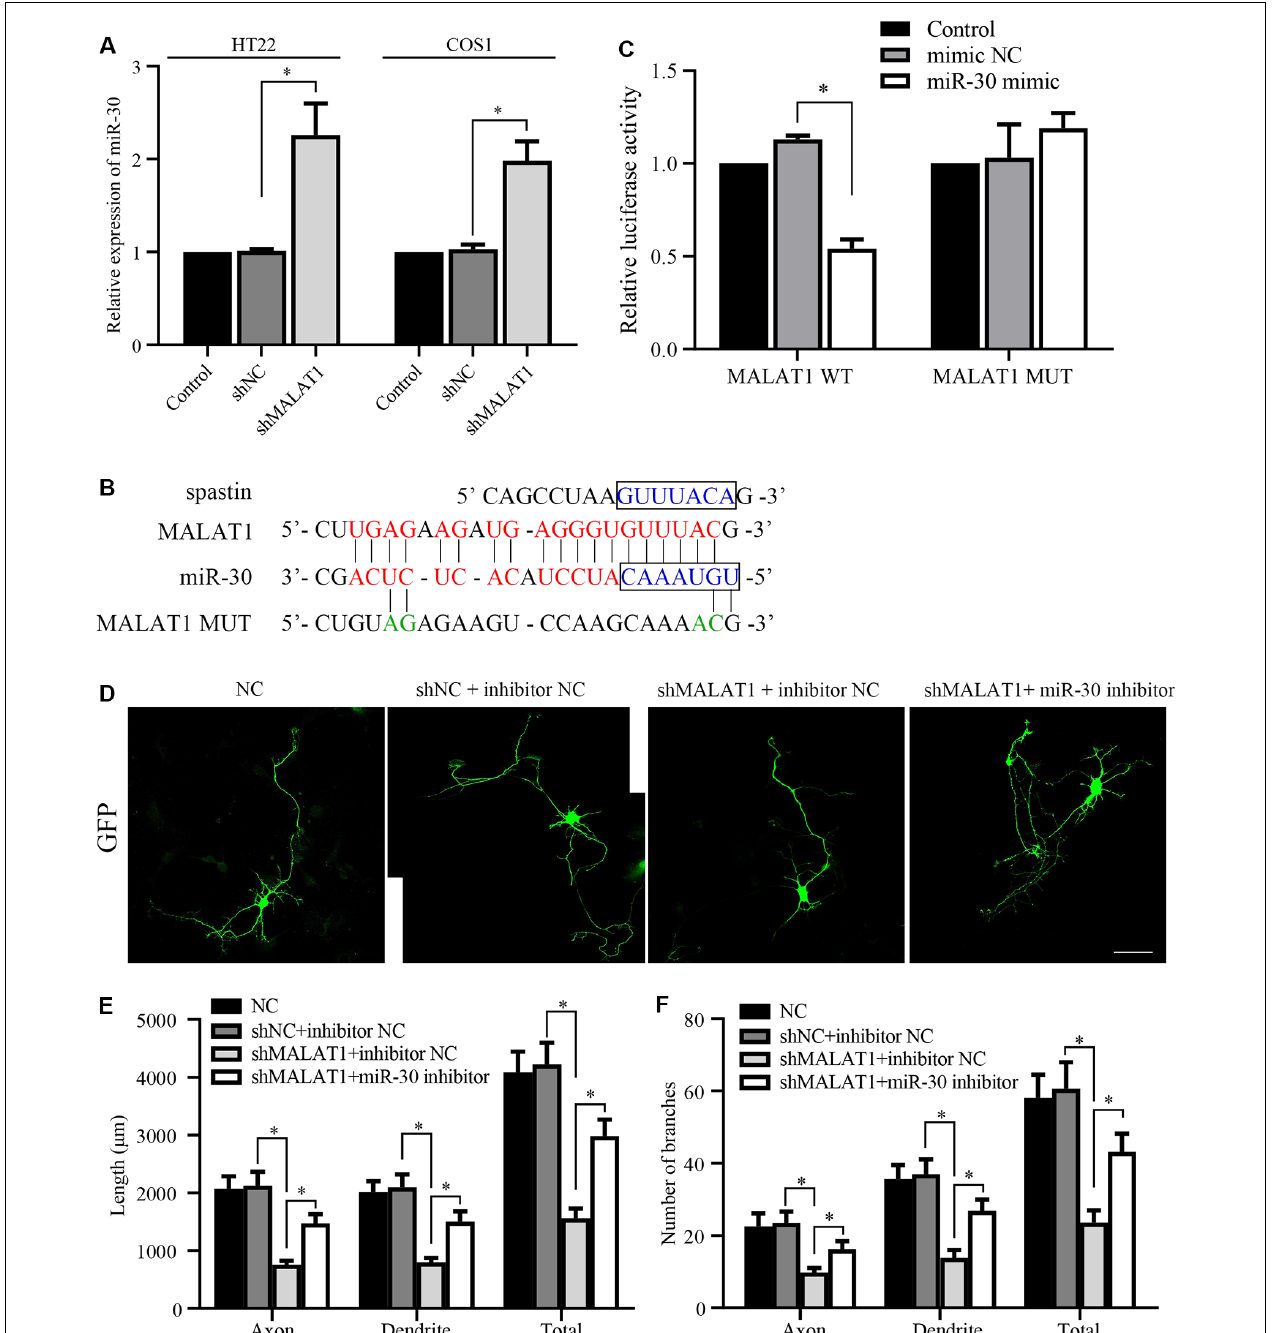
FIGURE 4 | lncRNA MALAT1 targets miR-30 during neural development. (A) The expression levels of miR-30 were determined by qPCR in HT22 and COS1 cells transfected with shMALAT1 or control plasmids. (B) Alignments of the luciferase reporter plasmids encoding MALAT1 WT or MUT against miR-30. (C) The reporter plasmids were transfected together with or without miR-30 mimics, and the relative luciferase activity was quantified. (D) Representative images of the cultured neurons that were transfected with the shMALAT1 plasmids or miR-30 inhibitors. Neurite lengths (E) and the number of branches (F) were quantified (neuron number > 30/group of each experimental repeat). ∗ P < 0.05; n = 3; Scale bar, 50 µ m.